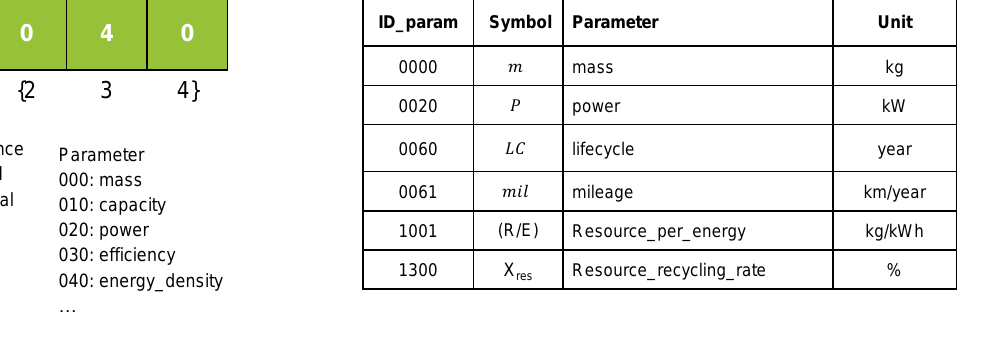
Figure 6. Explanation of the four-digit ID_param and examples.